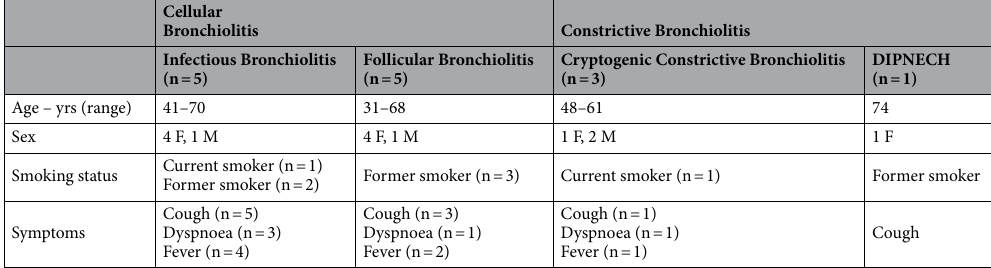
Table 1. Demographic and clinical features of patients with primary bronchiolar disorder.